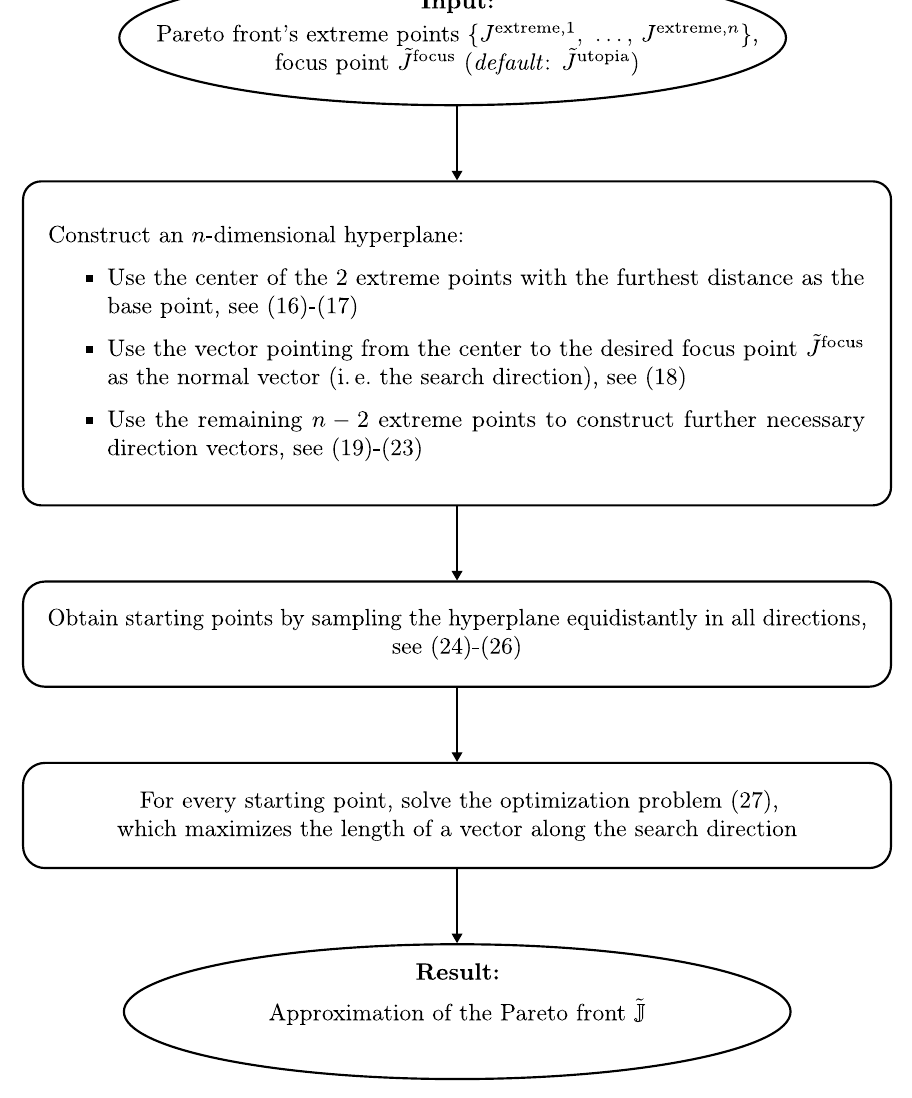
Figure 7. High-level flowchart diagram of the focus point boundary intersection method. Note that the unnormalized Pareto solutions J can be derived from ˜ J by rearranging